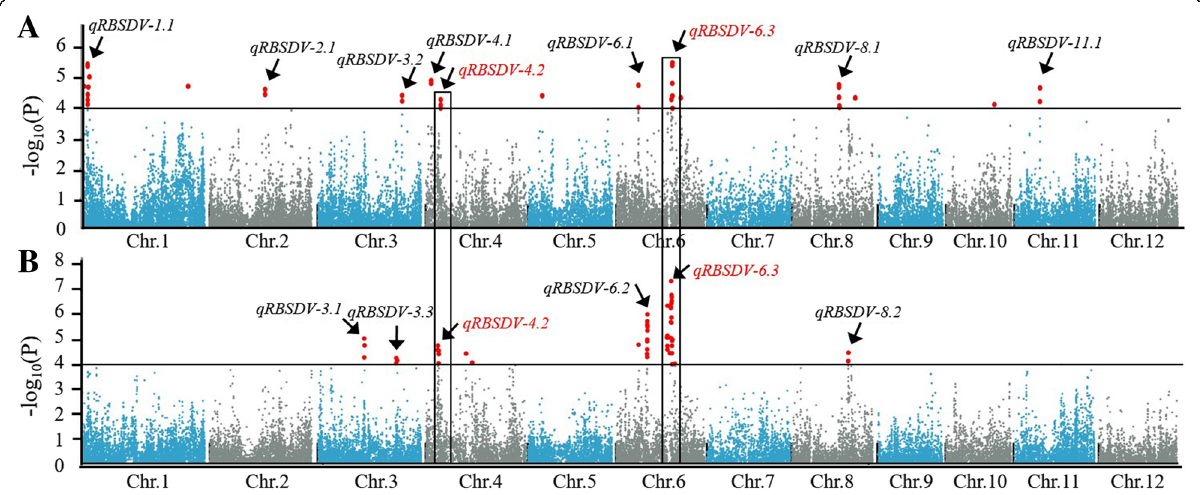
Fig. 4 Genome-wide association study of RBSDV resistance of 305 rice varieties. a and b Manhattan plots of MLM for the data obtained at Kaifeng ( a ) and Yutai ( b ). Black horizontal lines indicate the genome-wide significance threshold. Arrows indicate regions containing at least 2 significant-association markers which were designed as QTLs for RBSDV resistance. The two regions highlighted by rectangles indicate they were detected at both locations with consistent results